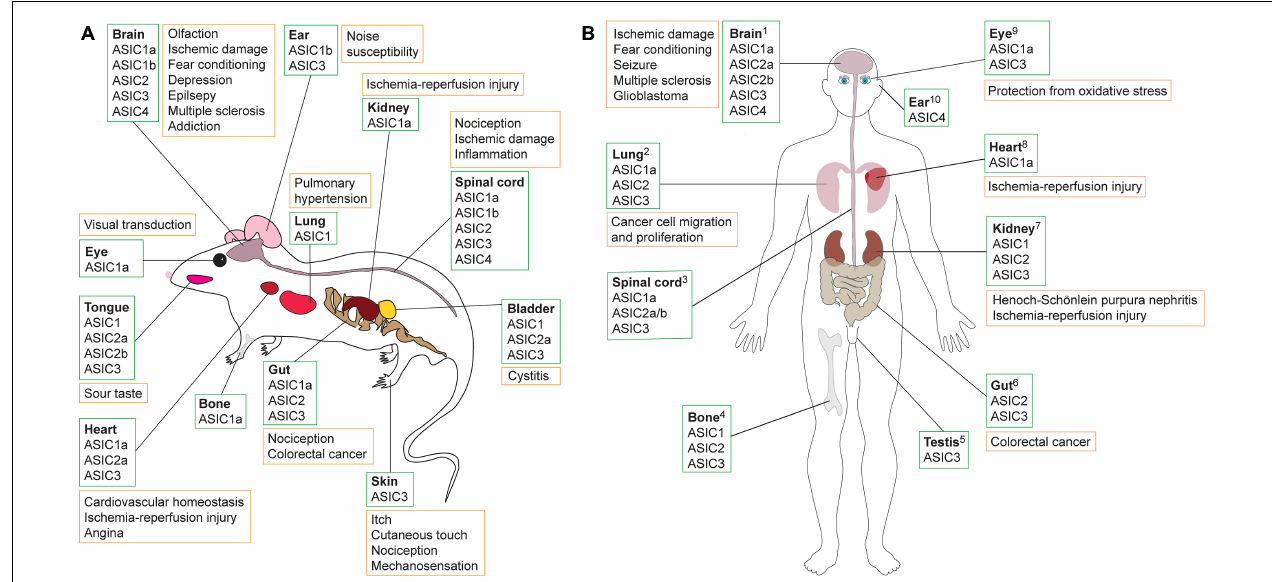
FIGURE 1 | Schematic showing tissues in which ASICs are expressed (green boxes) and their putative role in various pathologies (orange boxes) in (A) rodents and (B ) humans. Data summarized here are drawn from Supplementary Table 1 , with expression sites and pathology based on studies that used antibody staining, transcriptomic data, proteomics and/or functional methods. Additional information is available in the Human Protein Atlas (www.proteinatlas.org). References supporting the putative roles of ASICs in human pathologies are as follows: 1 Brain: ASIC1a detected using RT-PCR and Western blot; acidosis-mediated damage to cultured human brain neurons rescued by ASIC1a inhibition with PcTx1 (Li et al., 2010). Significant association between ASIC1a SNPs, amygdala volume, and panic disorder in humans (Smoller et al., 2014). Elevated levels of ASIC1a (Yang et al., 2016) and ASIC3 (Cao et al., 2016) in brains of patients with temporal lobe epilepsy shown using immunostaining and Western blot. ASIC expression in CNS; treatment with amiloride alleviated patient symptoms of MS (Arun et al., 2013). ASIC1 and ASIC3 found in glioblastoma stem cell lines using RT-PCR and Western blot; microarray data revealed that ASIC expression is associated with improved survival in glioma patients (Tian et al., 2017). 2 Lung: ASICs expressed in human lung cancer cell line A549 determined using RT-PCR, immunofluorescence, and Western blot. Proliferation and migration promoted by overexpression of ASIC1a and inhibited by PcTx1 (Wu et al., 2017). 3 Spinal cord: ASICs in human spinal cord, stained with ASIC1 antibody (Arun et al., 2013). 4 Bone: ASIC expression in human skeleton shown using RT-PCR and antibody staining performed on human chondrocytes (Jahr et al., 2005). 5 Testis: ASIC3 in human testis based on Northern blot (Ishibashi and Marumo, 1998). 6 Gut: ASIC2 measured using RT-PCR and immunostaining in human colorectal cancer cells, with ASIC2 promoting cell invasion and proliferation in xenografts (worsened via overexpression and impeded with ASIC2 knockout) (Zhou et al., 2017). 7 Kidney: ASICs found in human proximal tubular cell line using RT-PCR and Western blotting; apoptosis of cells due to ischemia-reperfusion injury reduced by ASIC1a inhibition using PcTx1 (Song et al., 2019). ASIC1, ASIC2 and ASIC3 protein expression in patients with Henoch-Schönlein purpura nephritis; ASIC blockade with amiloride reduced expression of damage marker proteins (Yuan et al., 2010). 8 Heart: Transcriptomics revealed presence of ASIC1a in human induced pluripotent stem cell-derived cardiomyocytes (hiPSC-CMs); ASIC1a inhibition with Hi1a or PcTx1 improved viability of hiPSC-CMs under conditions of hypoxia and acidosis, whereas viability was further reduced in the presence of the ASIC1a activator MitTx (Redd et al., 2021). 9 Eye: ASIC1a detected in retinal pigment epithelial cells using RT-PCR and Western blotting; PcTx1 protects cells from oxidative stress (Tan et al., 2013). ASIC3 mRNA detected using RT-PCR on human retina samples (Maubaret et al., 2002). 10 Ear: Presence of ASIC4 shown using RT-PCR and Northern blot (Gründer et al.,